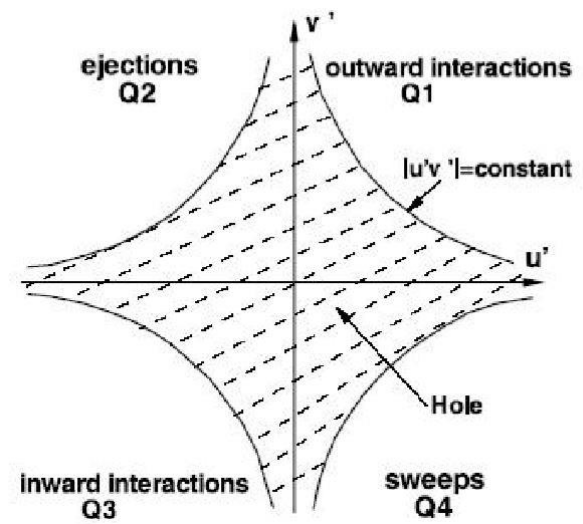
Figure 5. The four regions of interaction and the characteristics of the fluctuation .